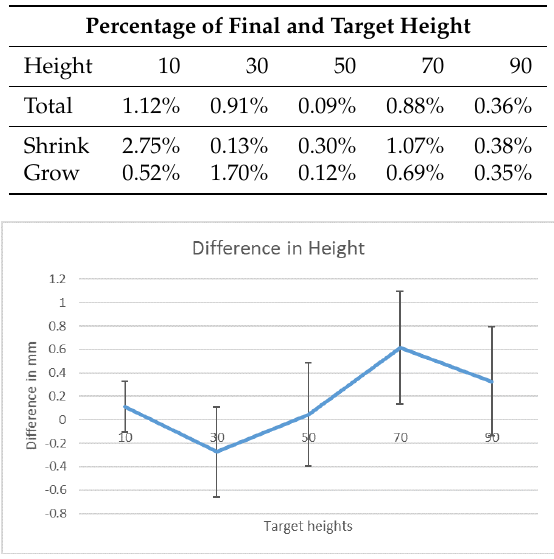
Table 8. Percentage from the final mean and target height in mm for height adjustment.